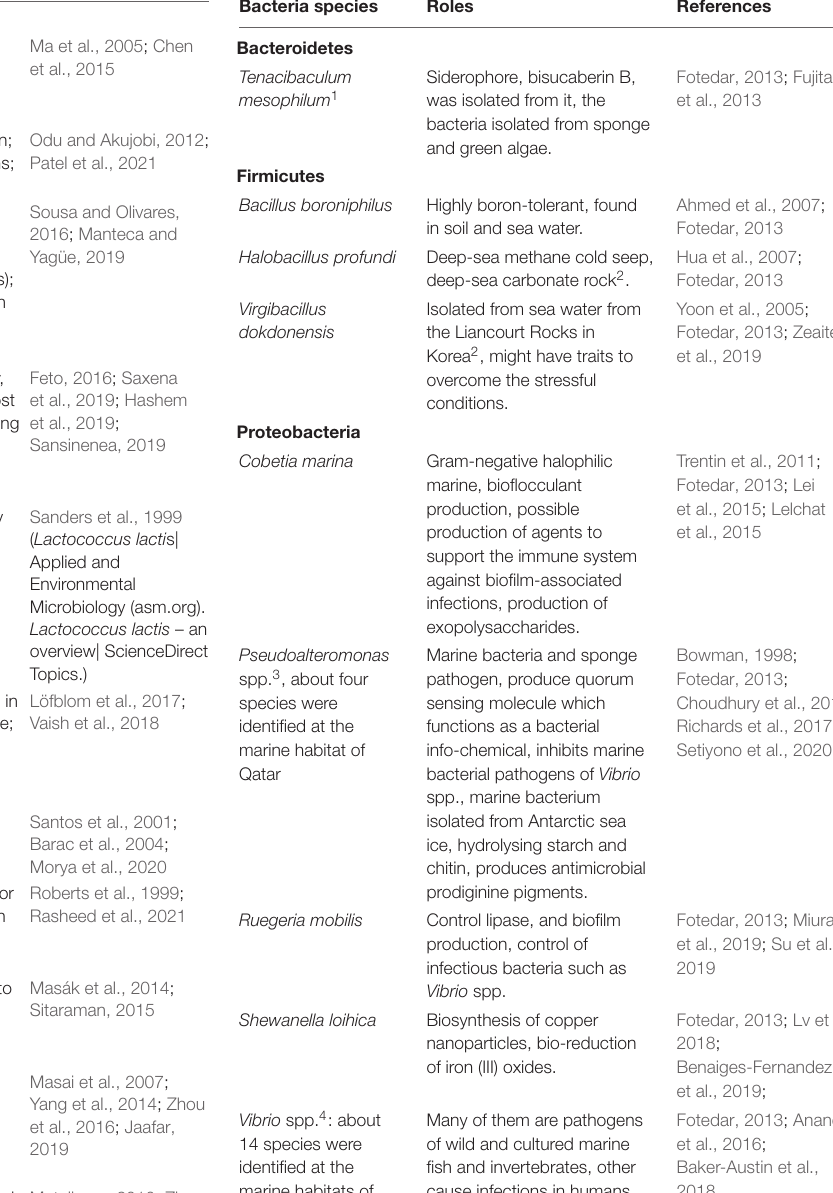
TABLE 4 | The reported roles of the bacterial species found in the Qatari desert. Bacterial species Phyla